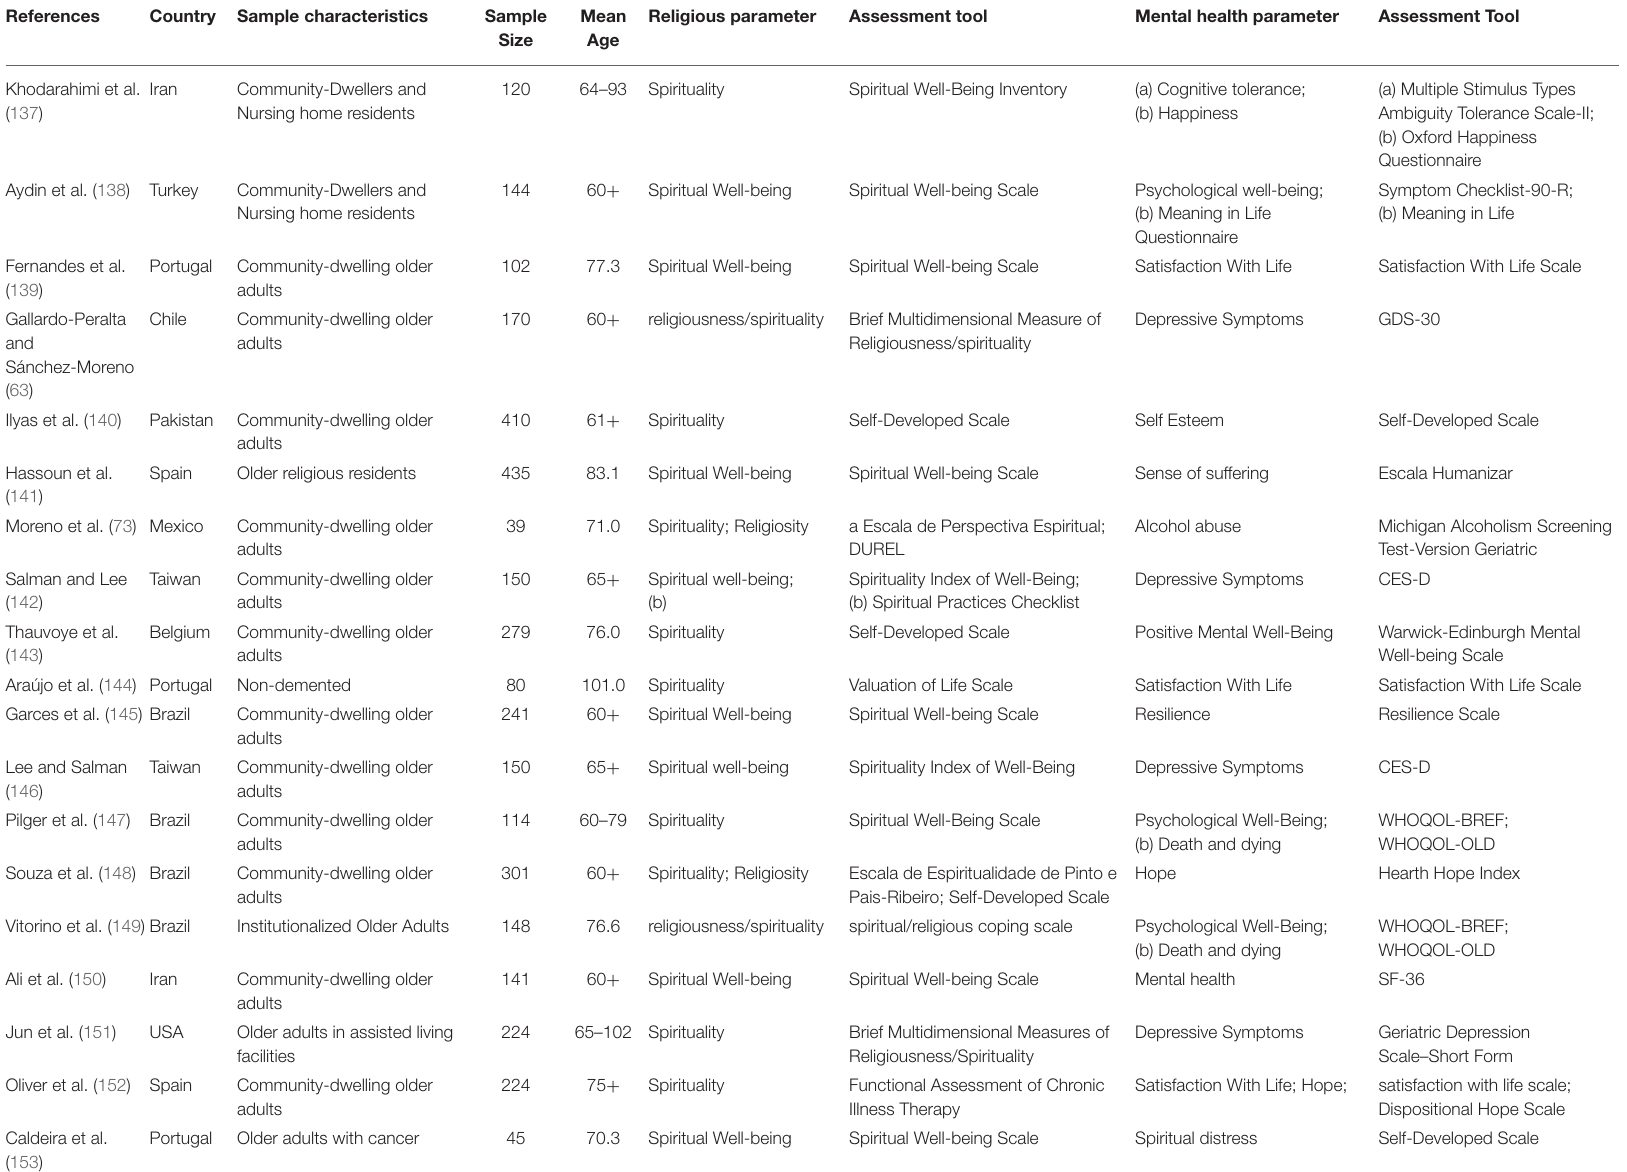
TABLE 2 | Main characteristics of the cross-sectional studies that investigated the association between spiritual activities and mental